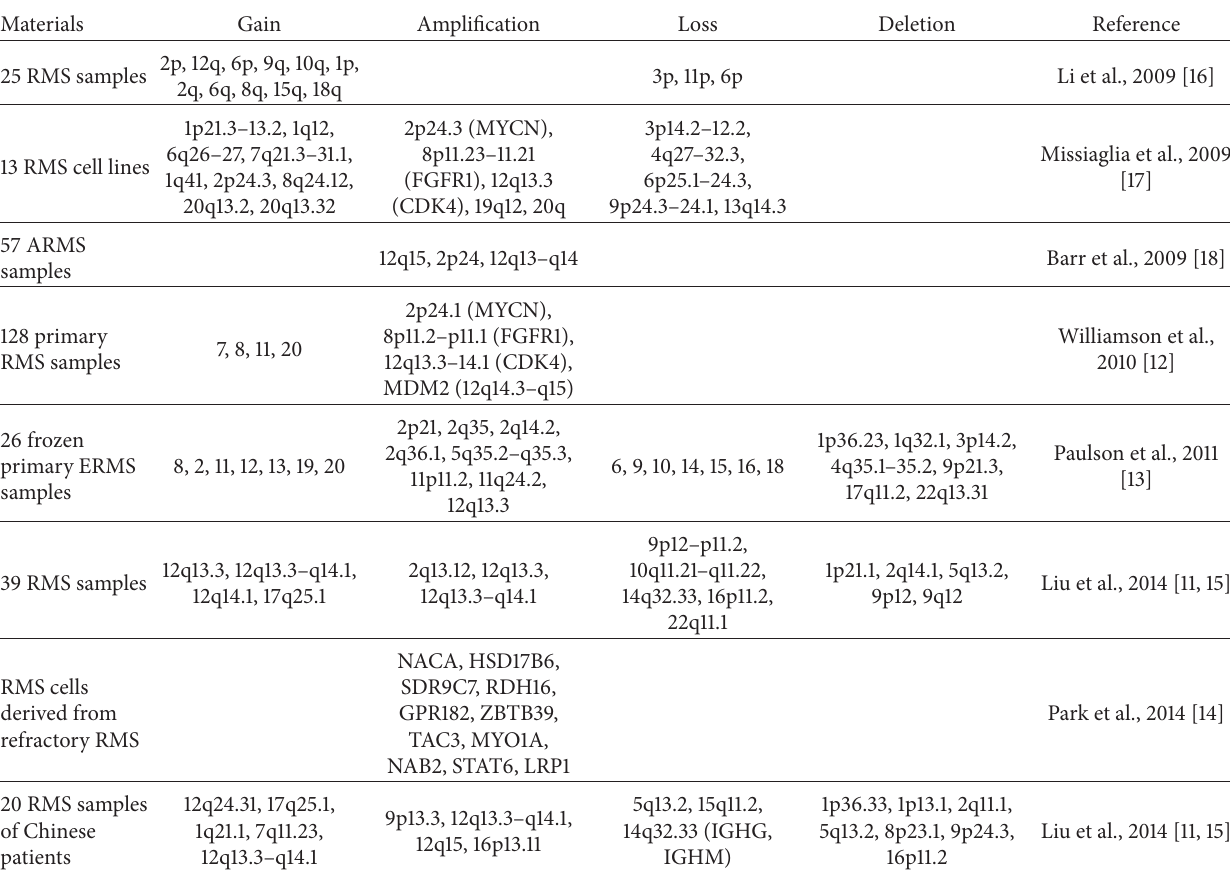
Table 1: Alterations of chromosome in RMS by CGH in recent 5